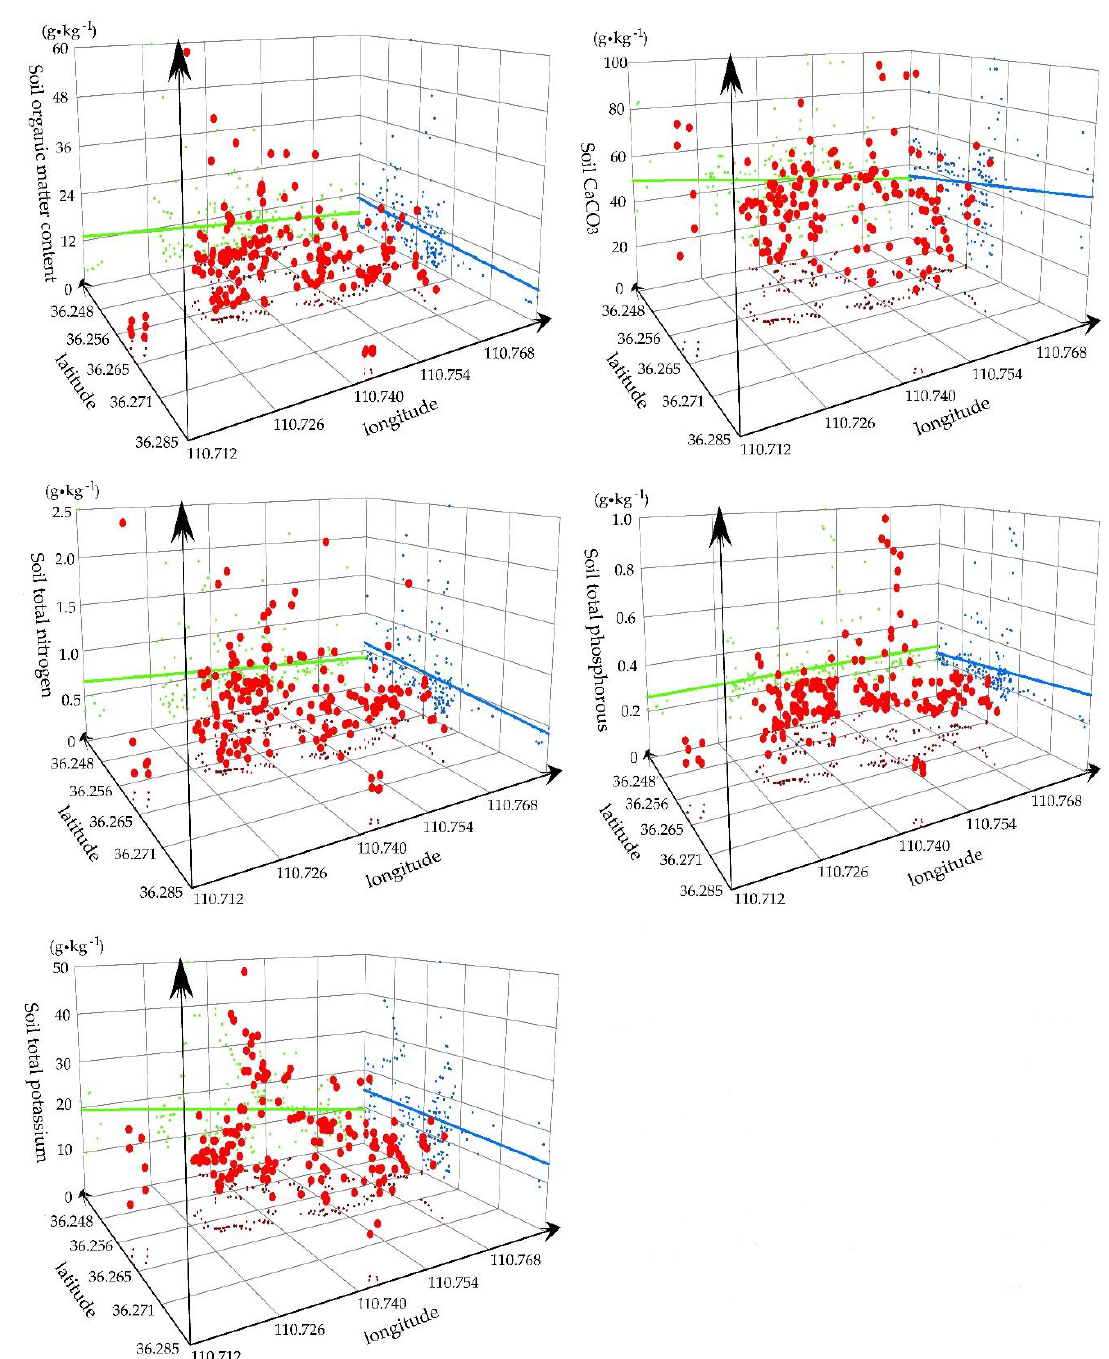
Figure 3. Spatial distributions of soil nutrients (soil total nitrogen, soil total phosphorous, total potassium, soil CaCO 3 , soil organic